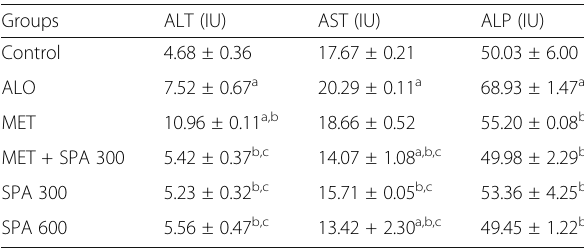
Table 1 Effect of methanol extract of S. sparganophora leaves on liver enzyme activities in alloxan-induced hyperglycemic rats Groups